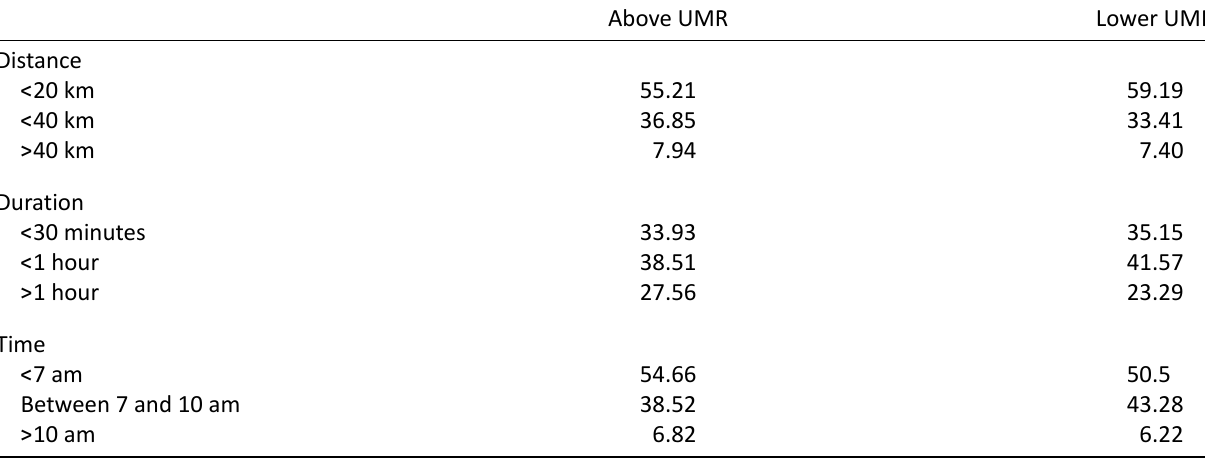
Table 5. Salary range proportion (%), by commuting characteristics.